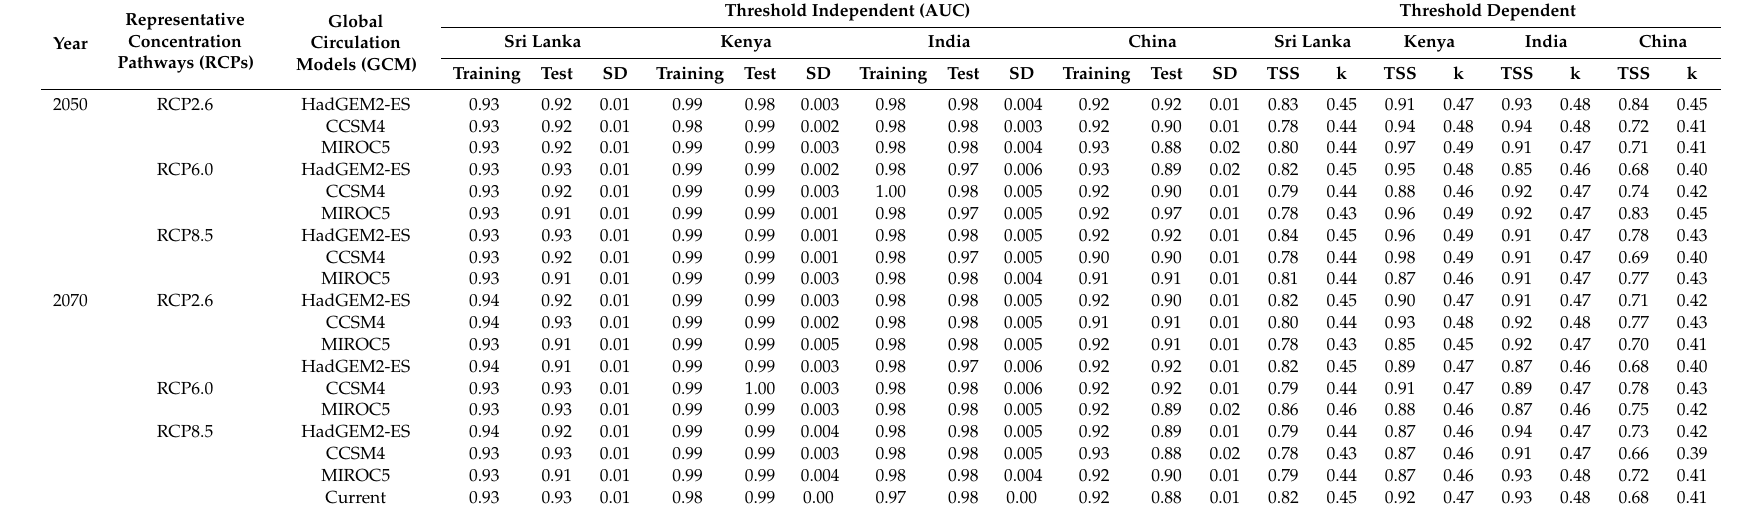
Table 1. Results of accuracy metrics (area under the receiver operating curve (AUC), true skill statistic (TSS) and kappa tests) for Camellia sinensis tested for the four tea-producing countries (SD: standard deviation, k: maximum